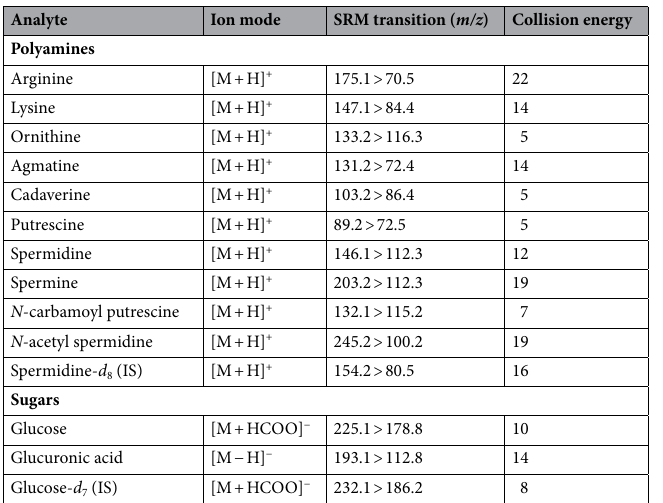
Table 1. Parameter for different selected reaction monitoring